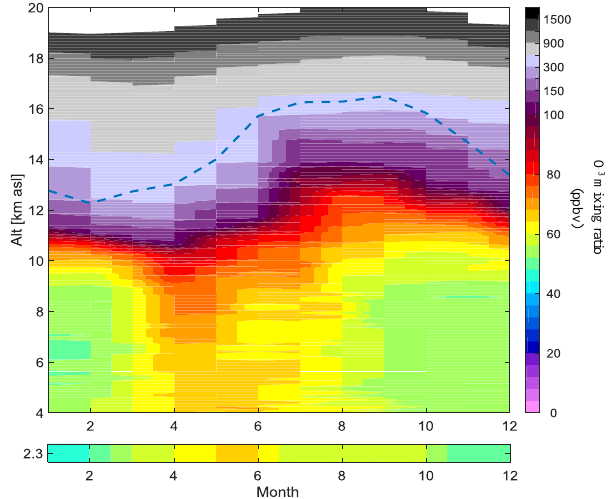
Figure 4. Composite monthly mean ozone mixing ratio (2000– 2015) computed from the TMF lidar measurements. The dashed line indicates the climatological tropopause above the site (WMO definition). Bottom strip: composite monthly mean ozone mixing ratio (2000–2015) from the surface